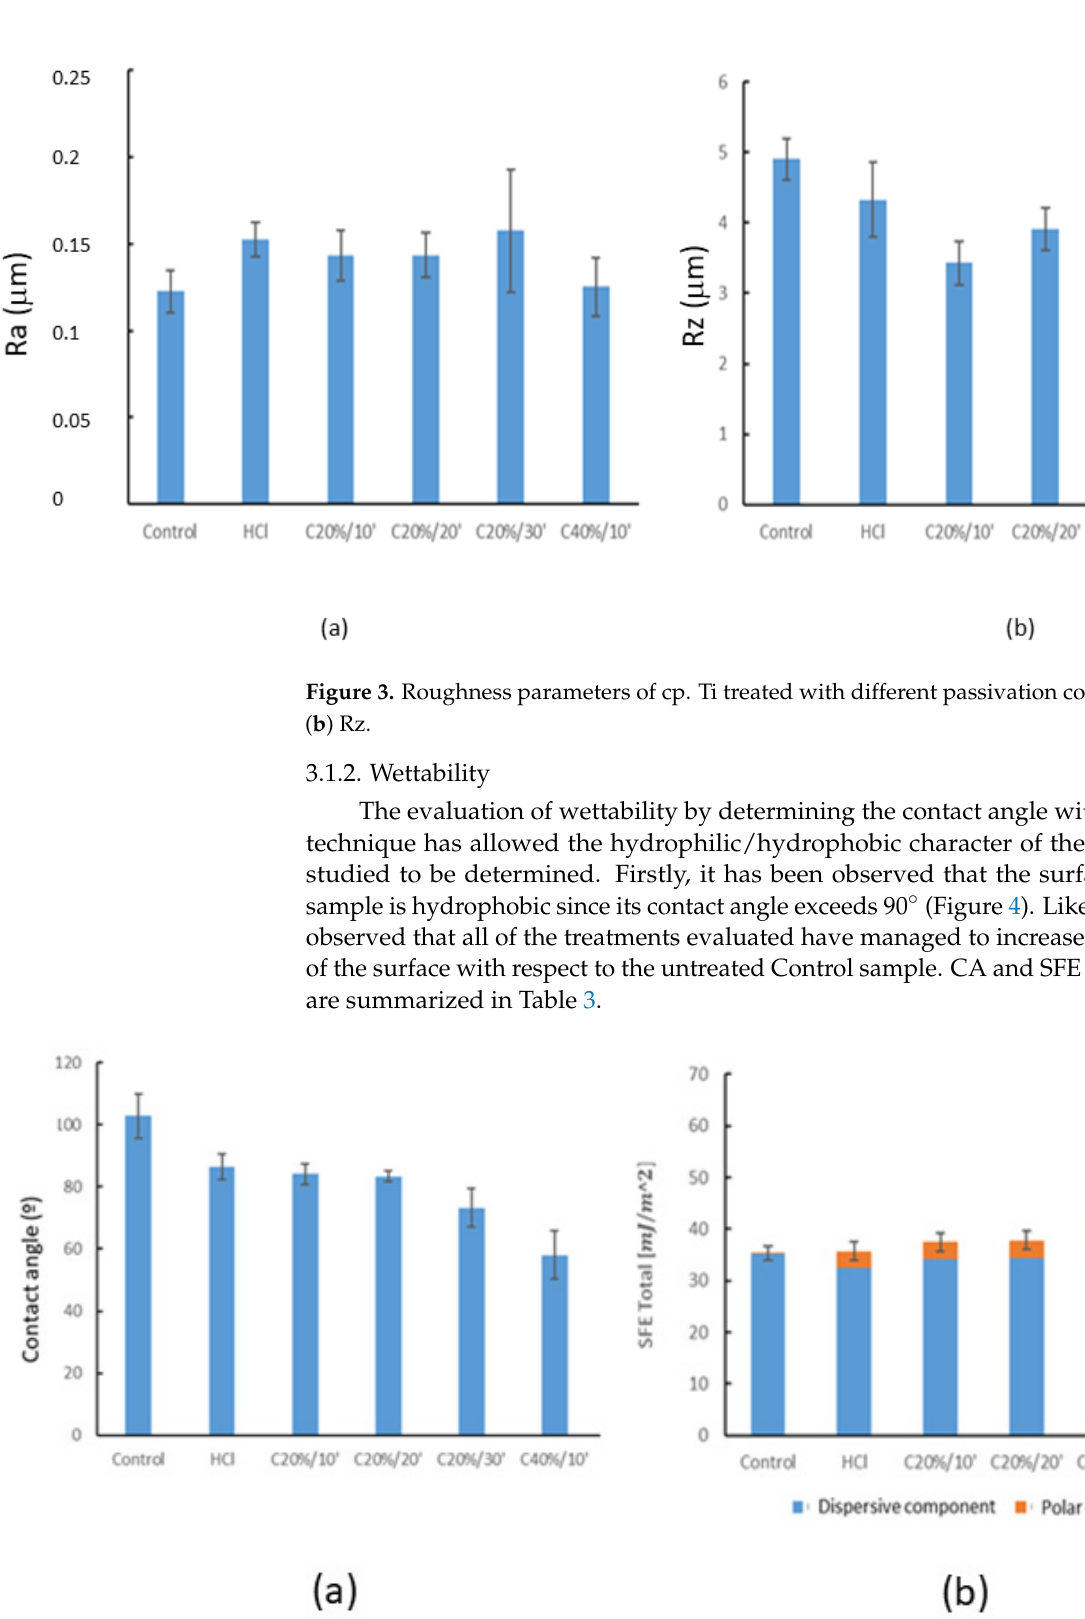
Figure 4. CA values ( a ) and SFE values ( b ) of cp. Ti treated with different passivation conditions. No statistically significant differences ( p > 0.05) were observed in the contact angle